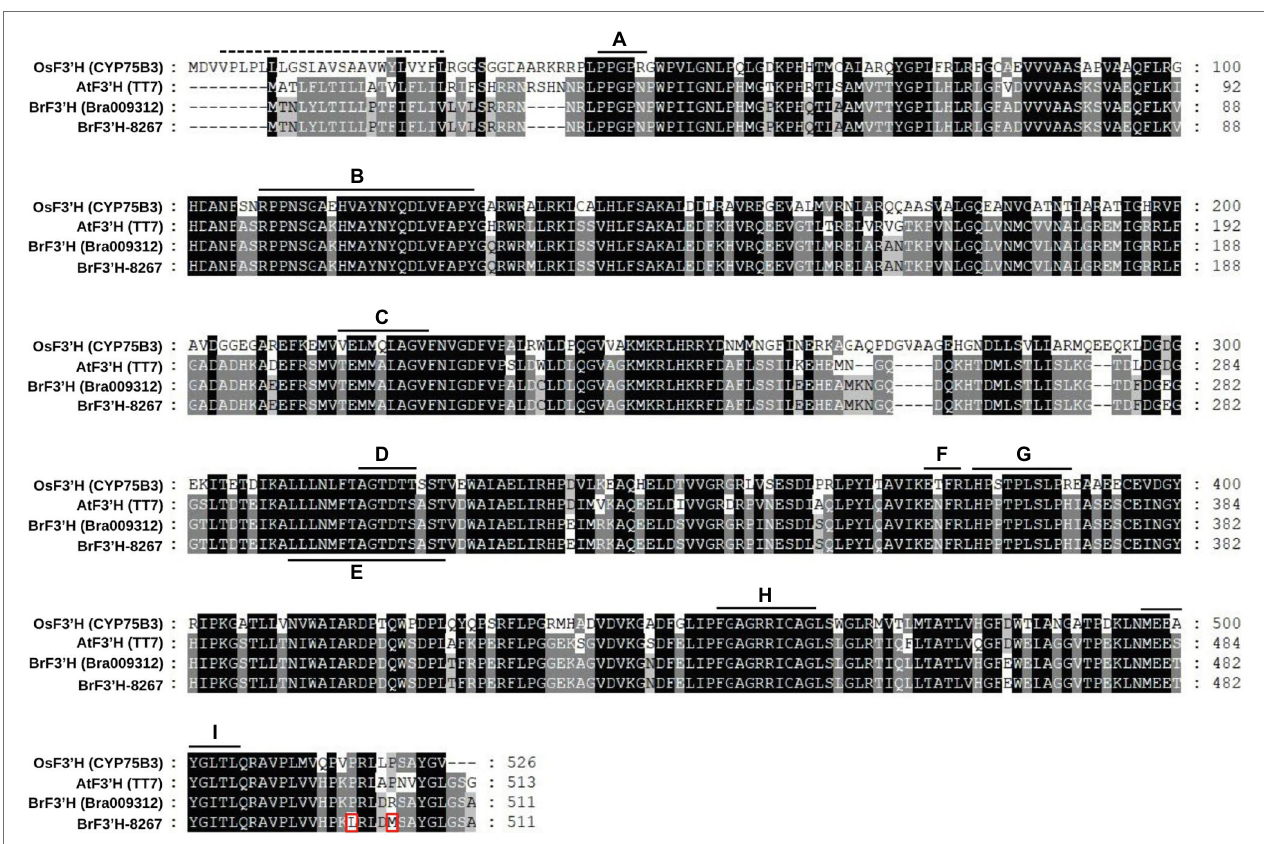
FIGURE 4 | Amino acid sequence alignment of Br F3 ′ Hs. The deduced amino acid sequence of Br F3 ′ H from 8267 was compared with those of other known F3 ′ Hs. Amino acid residues different from the reference sequence ( Bra009312 ) are indicated with red rectangles. The dashed line located in the N-terminal region indicates the predicted membrane-spanning anchors, and solid lines indicate specific conserved regions of cytochrome P450 enzymes. A, hinge region; B, substrate recognition site 1 (SRS1); C, SRS2; D, oxygen binding pocket; E, SRS4; F, ExxR motif; G, SRS5; H, heme-biding domain; I,